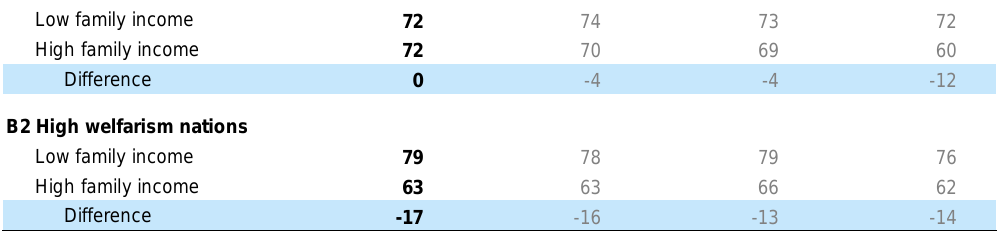
Figure A9. Alternative measures of welfarism and attitudes toward income redistribution: Cross-level interaction between family income and the nation’s level of welfarism. Panel A: Multilevel regression estimated by GLS. Panel B: Predicted values of support for redistribution implied by these regressions evaluated for those with low family income (bottom 10%) and those with high (top 10%), separately for low welfarism nations (approximately bottom 10%) and high welfarism nations (top 10%).